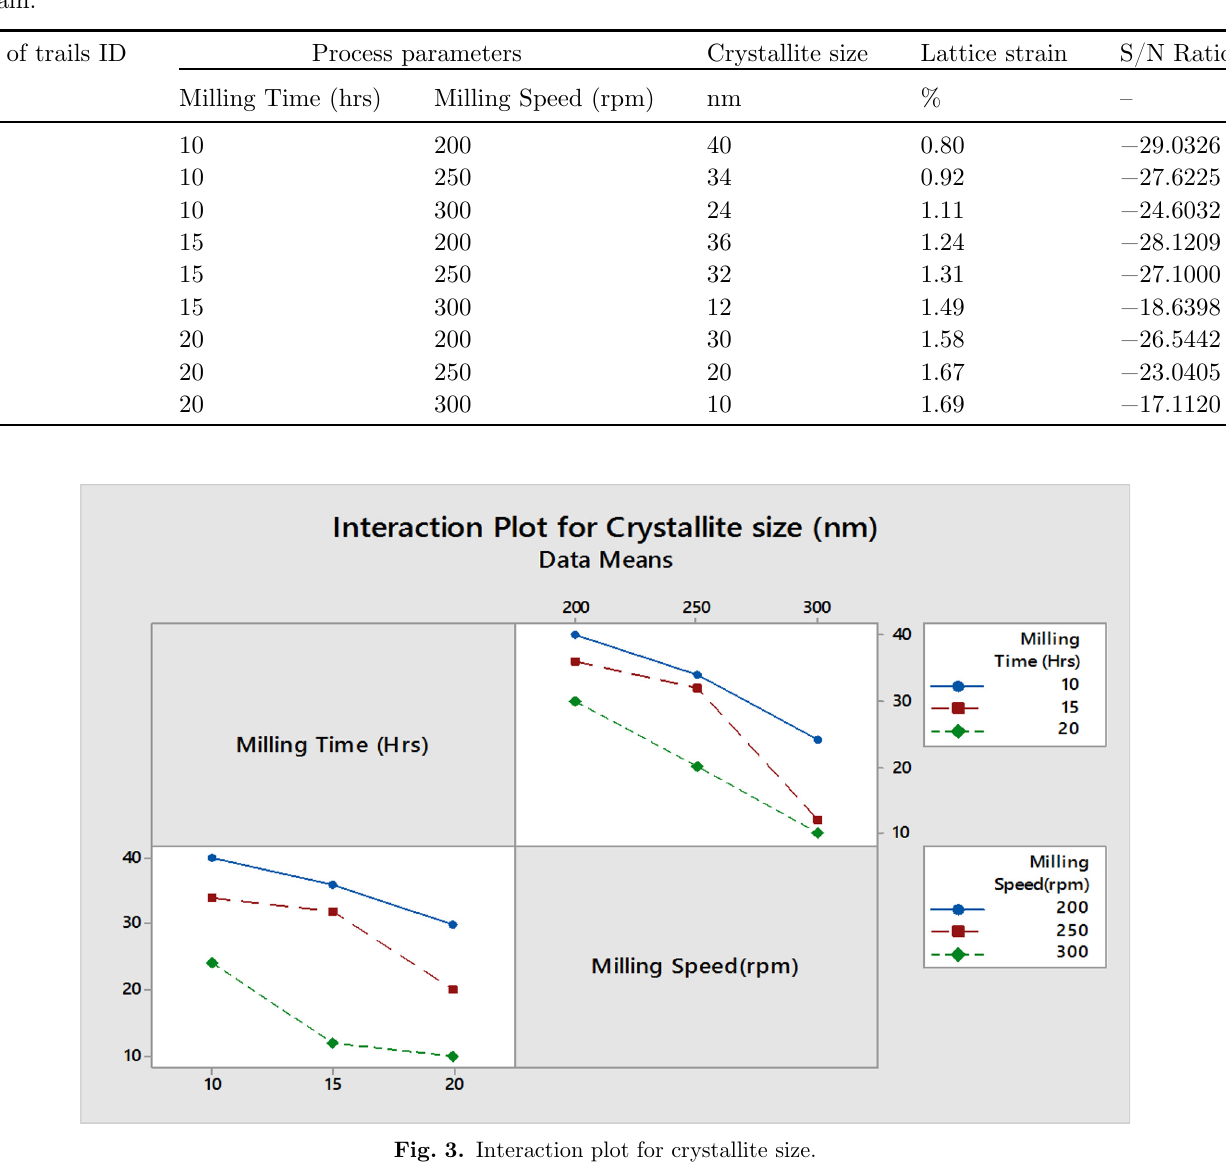
Table 3. Design of L orthogonal array used for Taguchi analysis and calculated values of crystallite size and lattice 9 strain.